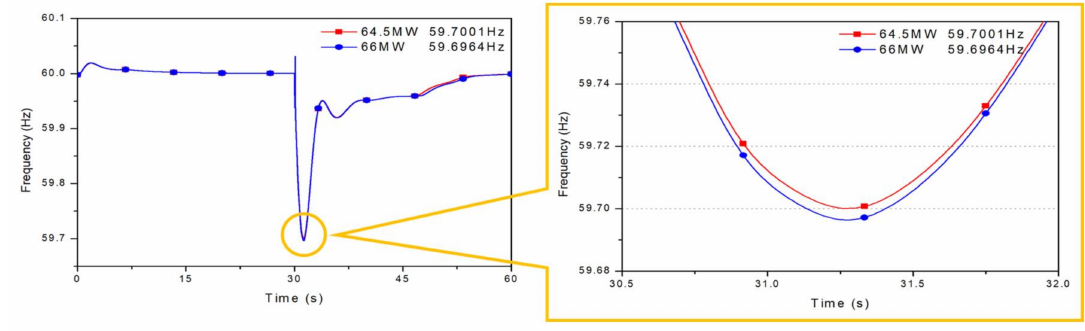
Figure 10. Frequency of Jeju power system on the merit order 2 when the wind farm is lost.